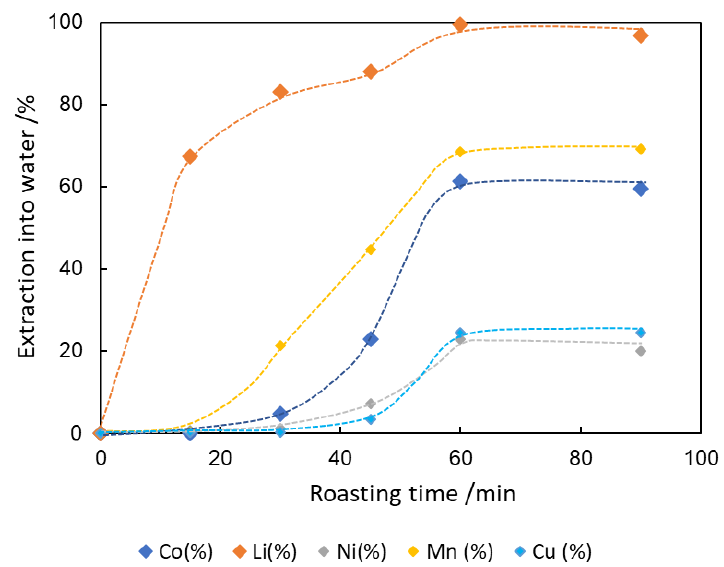
Figure 12. Extraction (%) of metals into water as a function of roasting time from black mass by sulfation roasting with 10% SO 2 -10% O 2 -Ar gas at 850 °C in the presence of carbon.